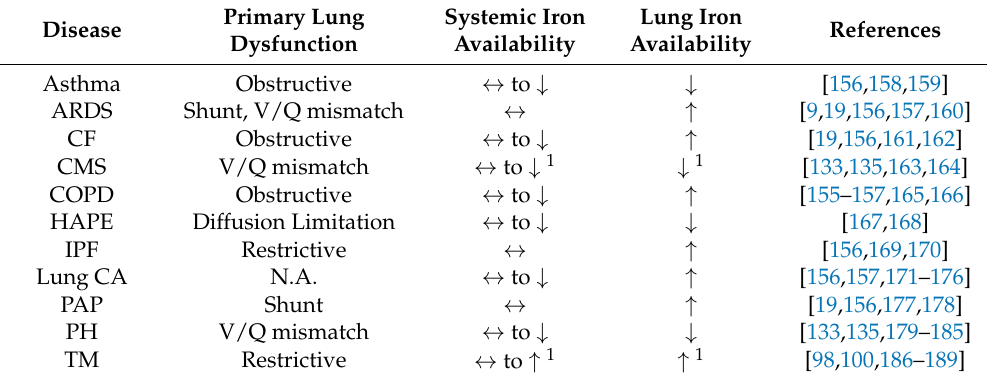
Table 1. Lung diseases and other diseases with a pathological lung phenotype associated with disturbed iron